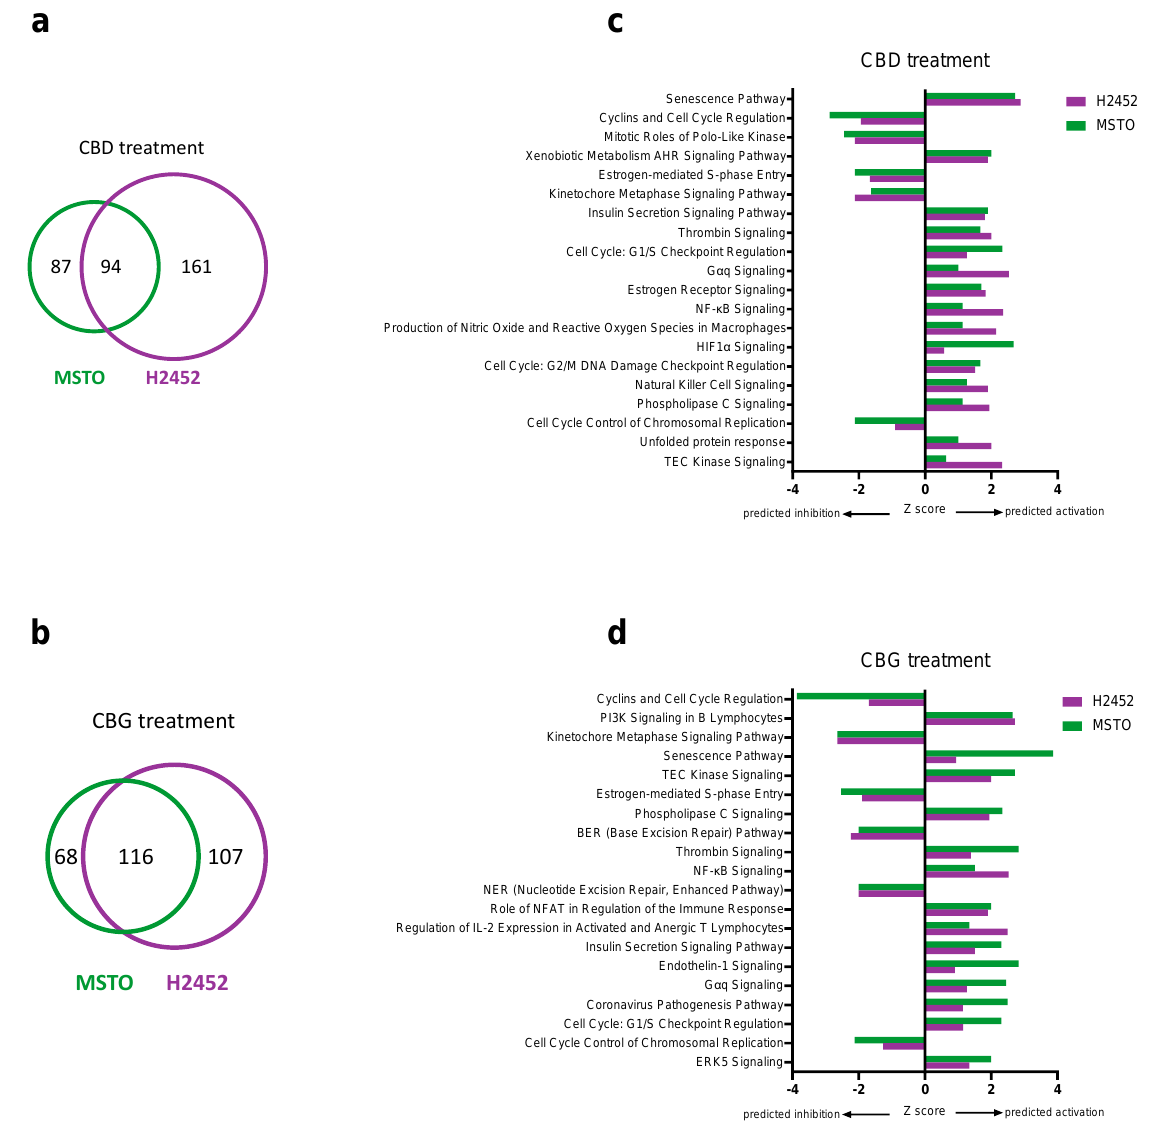
Figure 6. Differentially expressed genes and pathway analysis associated with cannabidiol (CBD) and cannabigerol (CBG) treatment. The number of genes found to be differentially expressed ( a , b ) and top shared canonical pathways ( c,d ) as a result of CBD ( a , c ) and CBG ( b , d ) treatment in human MSTO and H2452 mesothelioma cell lines. Analysis was performed relative to vehicle treated control cells and only includes genes with FC > 2. Overlapping areas in Venn diagrams ( a , b ) indicate the number of shared genes found to be differentially expressed in the same direction in both cell lines. Z-scores ( c , d ) indicate predicted activation state of the top significantly enriched canonical pathways with values < 0 indicating inhibition and values > 0 indicating activation.